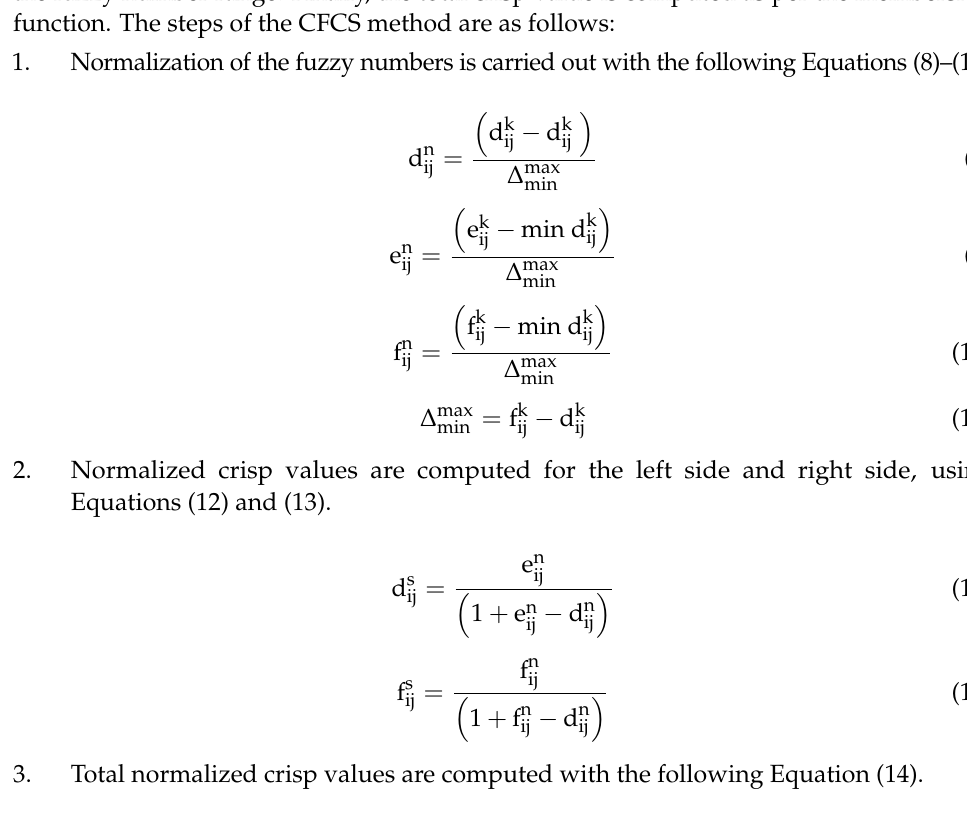
3. Total normalized crisp values are computed with the following Equation (14).